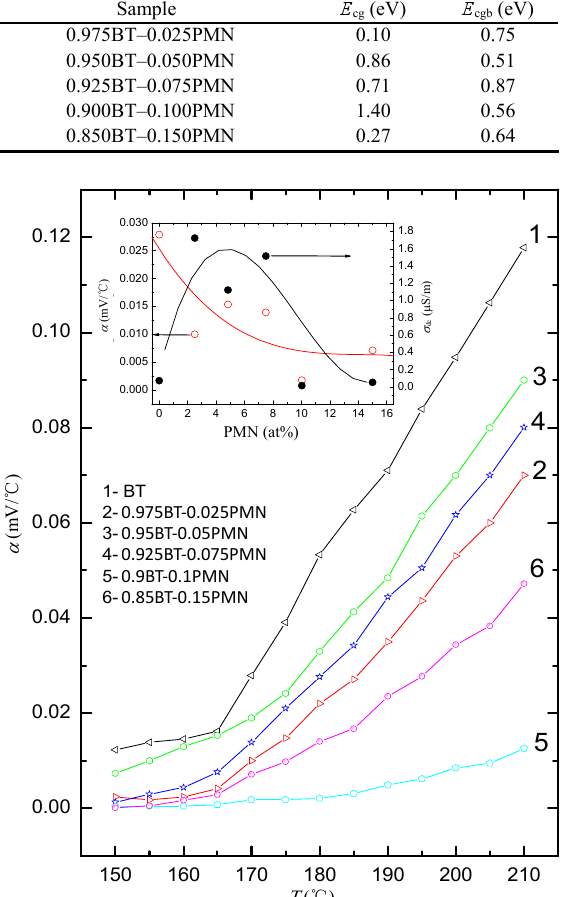
Fig. 10 Seebeck coefficient as a function of temperature for (1  x )BT– x PMN ceramics. Inset shows the Seebeck coefficient and electric conductivity obtained at 170 ℃ vs. PMN content. The solid lines are only an